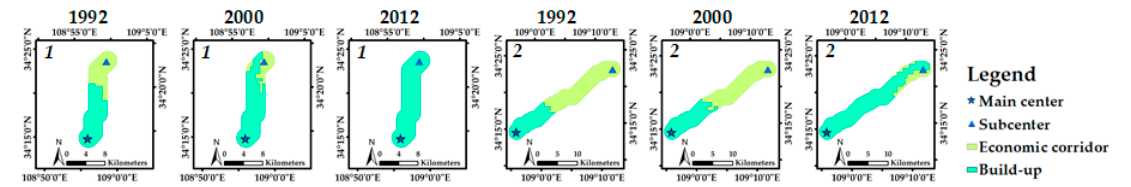
Figure 11. Results of the built-up areas within the economic corridor of Wuhan. Fig ure 11. Results of the built-up areas within the economic corridor of Wuhan.